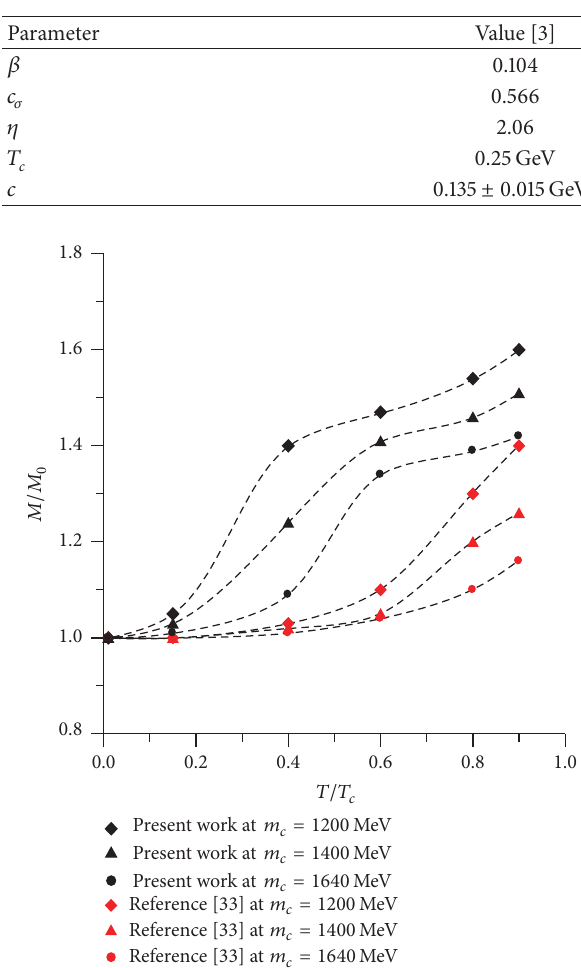
Table 1: The parameters of the internal energy.